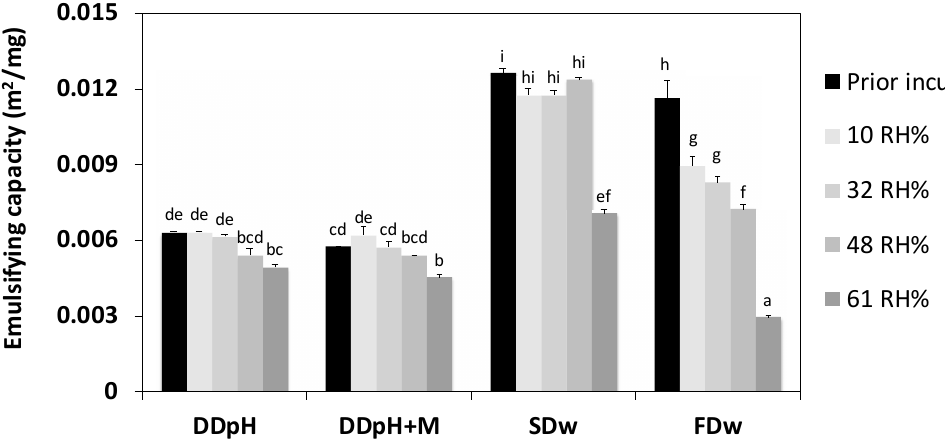
Figure 5. Emulsifying capacity of thylakoid powders produced in di ff erent ways after 8 months storage in controlled atmosphere with di ff erent relative humidity. DD pH = drum-dried powder produced by the pH method, DD pH + M = drum-dried powder produced by the pH method with addition of maltodextrin, SD w = spray-dried powder produced by the water method, FD w = freeze-dried powder produced by the water method. Di ff erent letters indicate significant di ff erence ( p < 0.05). The particle size of lipid droplets stabilized by thylakoid powder stored at 8 months in 61 RH% was increased compared to lipid droplets stabilized by thylakoid powders prior incubation (Figure 6). This indicates reduced emulsifying capacity of the membranes during storage in high relative